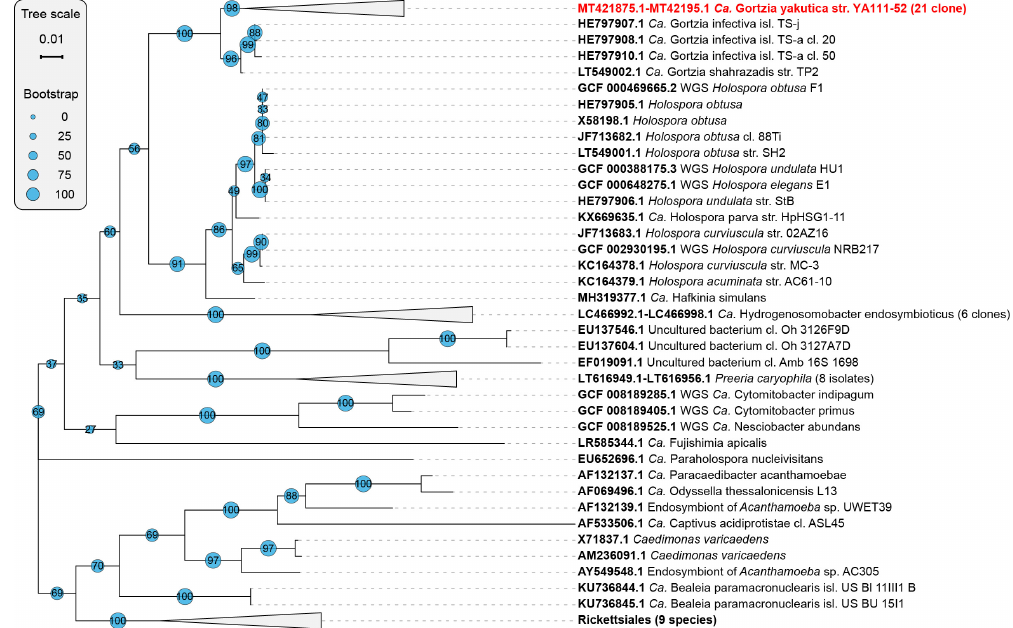
Figure 6. Maximum likelihood phylogenetic tree of the order Holosporales . Bootstrap support values are shown on each branch. Clones, highly similar isolates, and 9 outgroup sequences from Rickettsiales are collapsed. Full list of Genbank sequence identifiers is available in Table